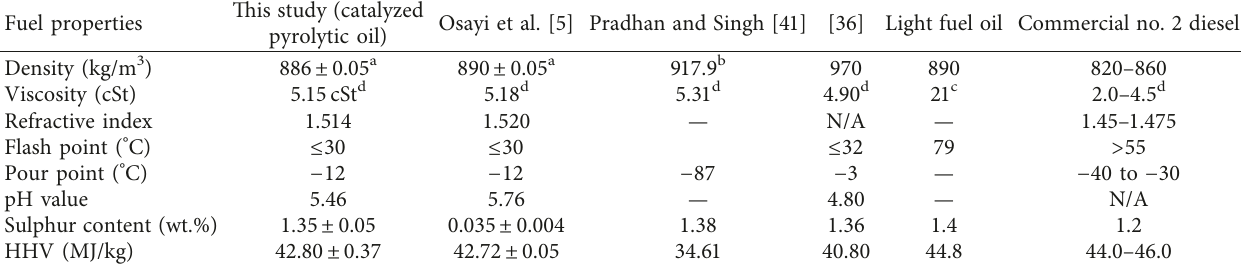
Table 4: Fuel properties determined for the catalyzed pyrolytic oil